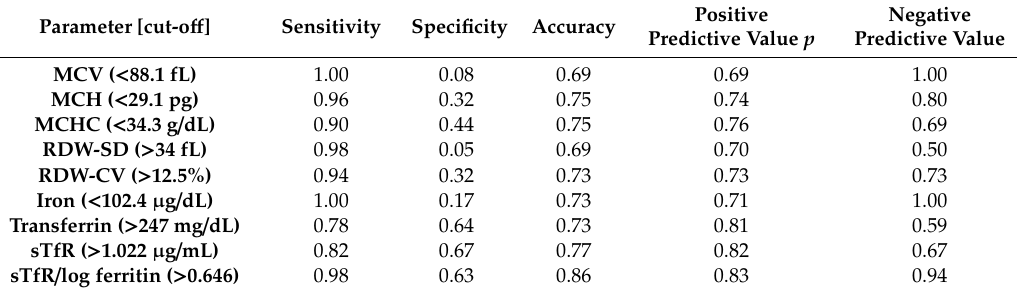
Table 2. Measures of diagnostic utility of analyzed parameters for discriminating iron deficiency in children with IBD .